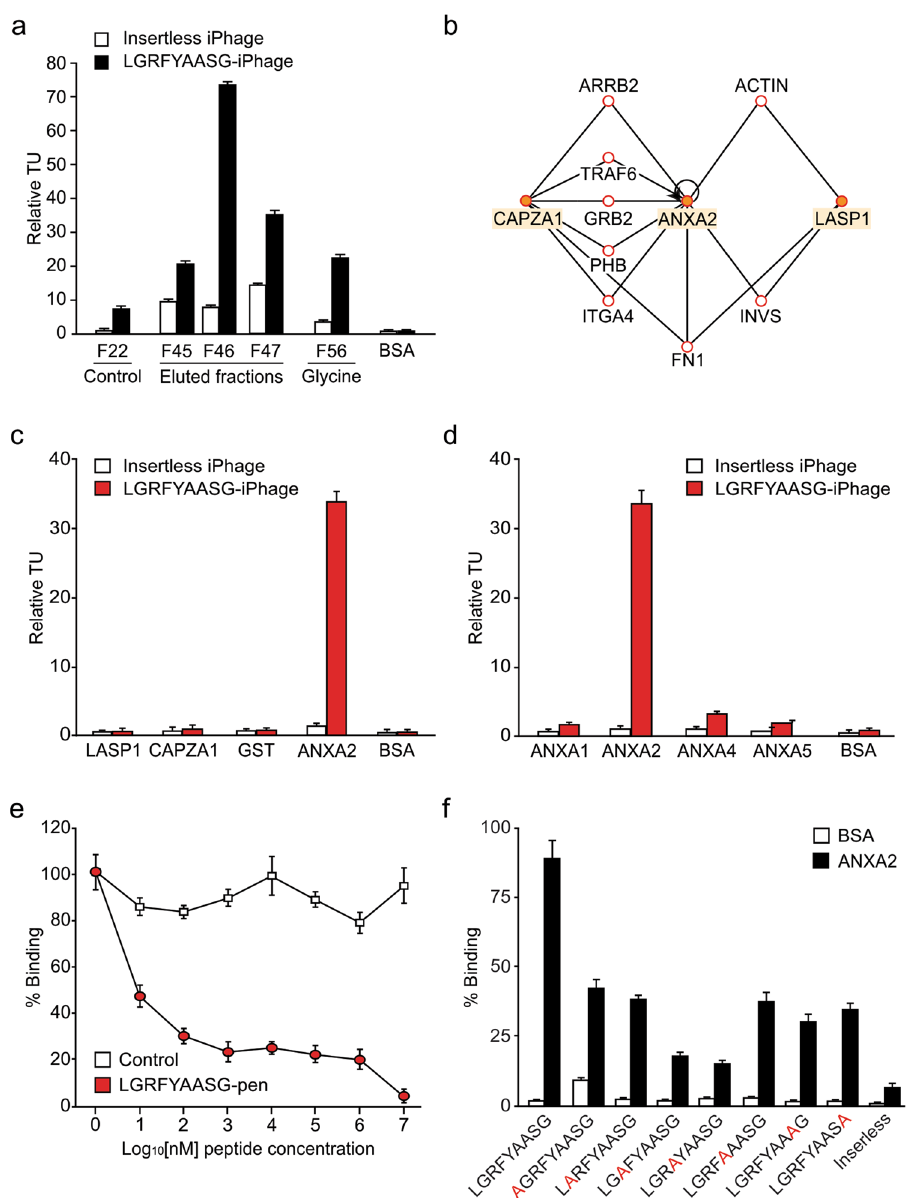
Figure 1. The LGRFYAASG peptide motif is a specific intracellular ligand for annexin A2. ( a ) iPhage binding assays on protein fractions obtained by affinity chromatography. BSA was used as a negative protein control. TU values were normalized on binding of the insertless iPhage to annexin A2. ( b ) In silico analysis of potential interactions among the mass spectrometry-identified proteins in the canonical actin cytoskeleton pathway, as determined by the IPA protein network prediction software. ANXA2, annexin A2. ( c ) Binding of iPhage to GST-fused recombinant annexin A2, LASP1, and CAPZA1. GST and BSA served as protein controls. ( d ) Binding of LGRFYAASG-iPhage to recombinant annexin A1 (ANXA1), A2 (ANXA2), A4 (ANXA4), and A5 (ANXA5). ( e ) Binding of LGRFYAASG-iPhage to annexin A2 in the presence of increasing concentrations of the synthetic peptide LGRFYAASG-pen. Unconjugated pen was used as a control, and binding in the absence of the inhibiting peptide was set at 100%. ( f ) Binding of alanine scanning variants of LGRFYAASG-iPhage. TU values were normalized on binding of an insertless iPhage, and bars represent mean values of triplicate experimental points ± standard error of the mean